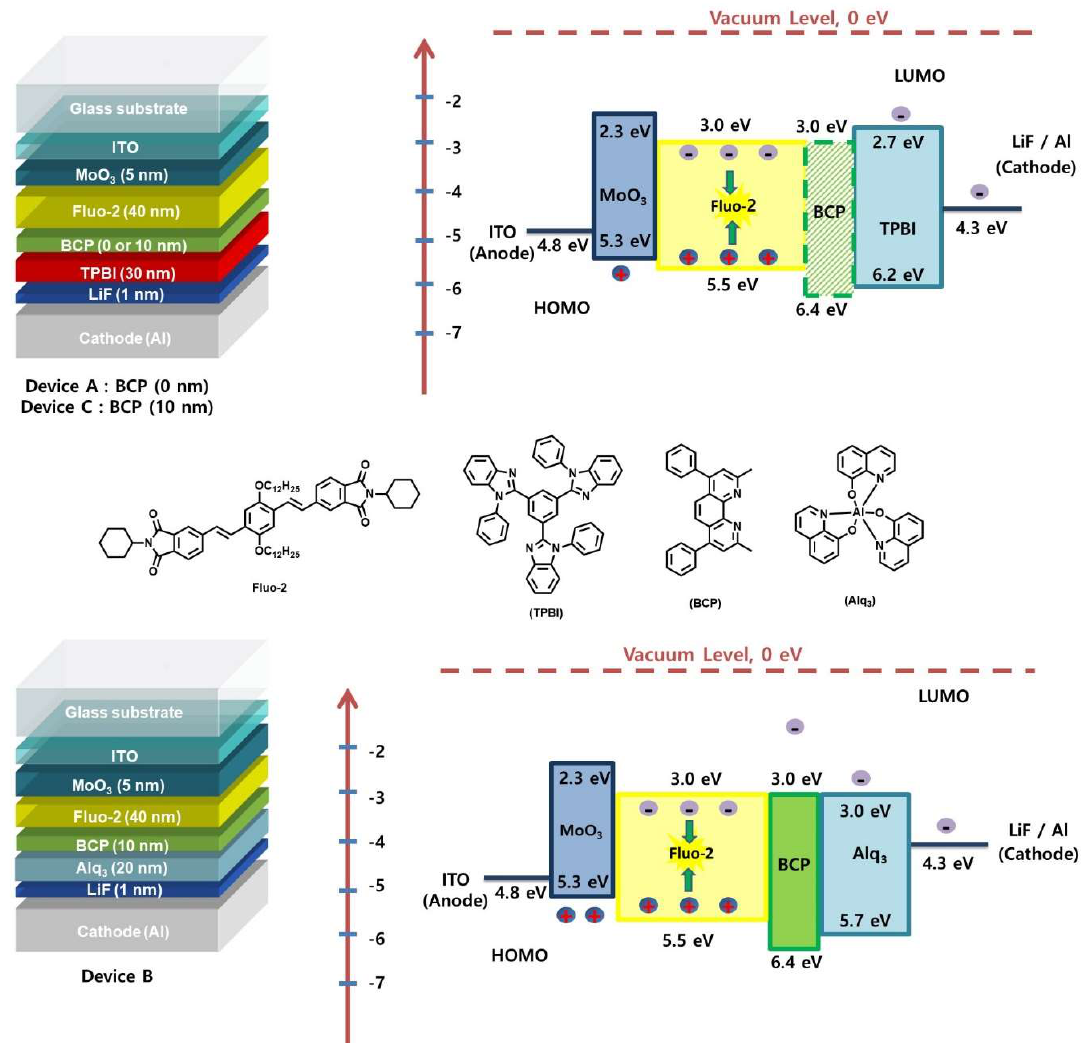
Figure 2. Device configurations and formulas of the different materials used to fabricate organic light- emitting diodes (OLEDs).